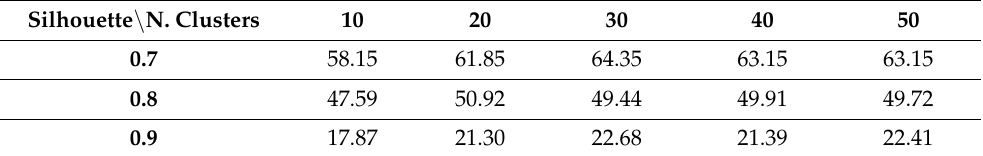
Table 57. Clustering performance in terms of silhouettes using the reduced dataset with SPQR. Silhouette \ N. Clusters